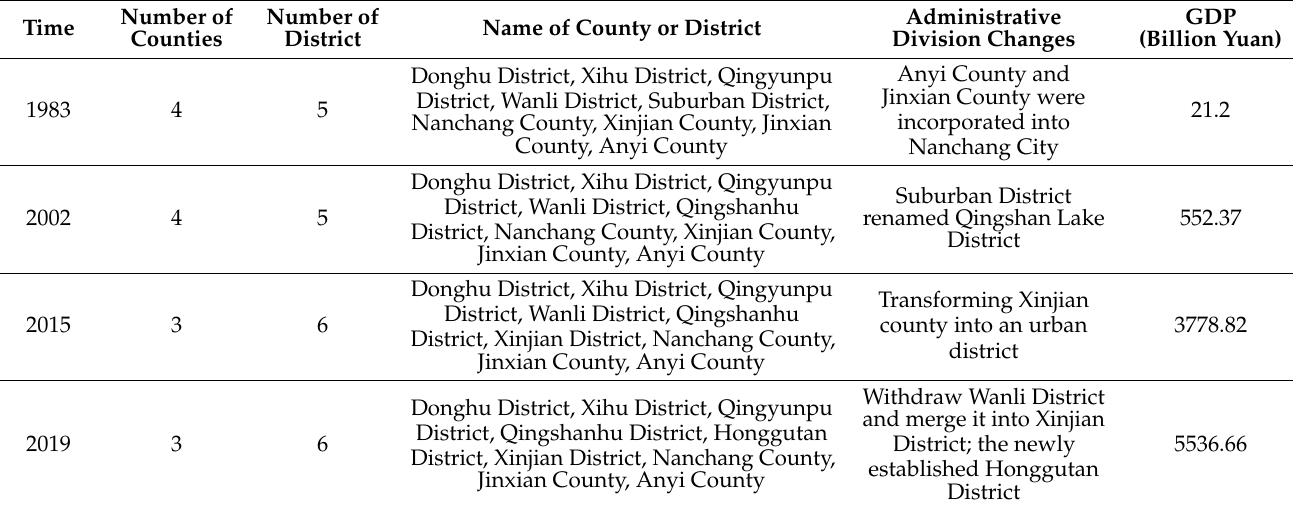
Table A1. Changes in the administrative divisions of Nanchang